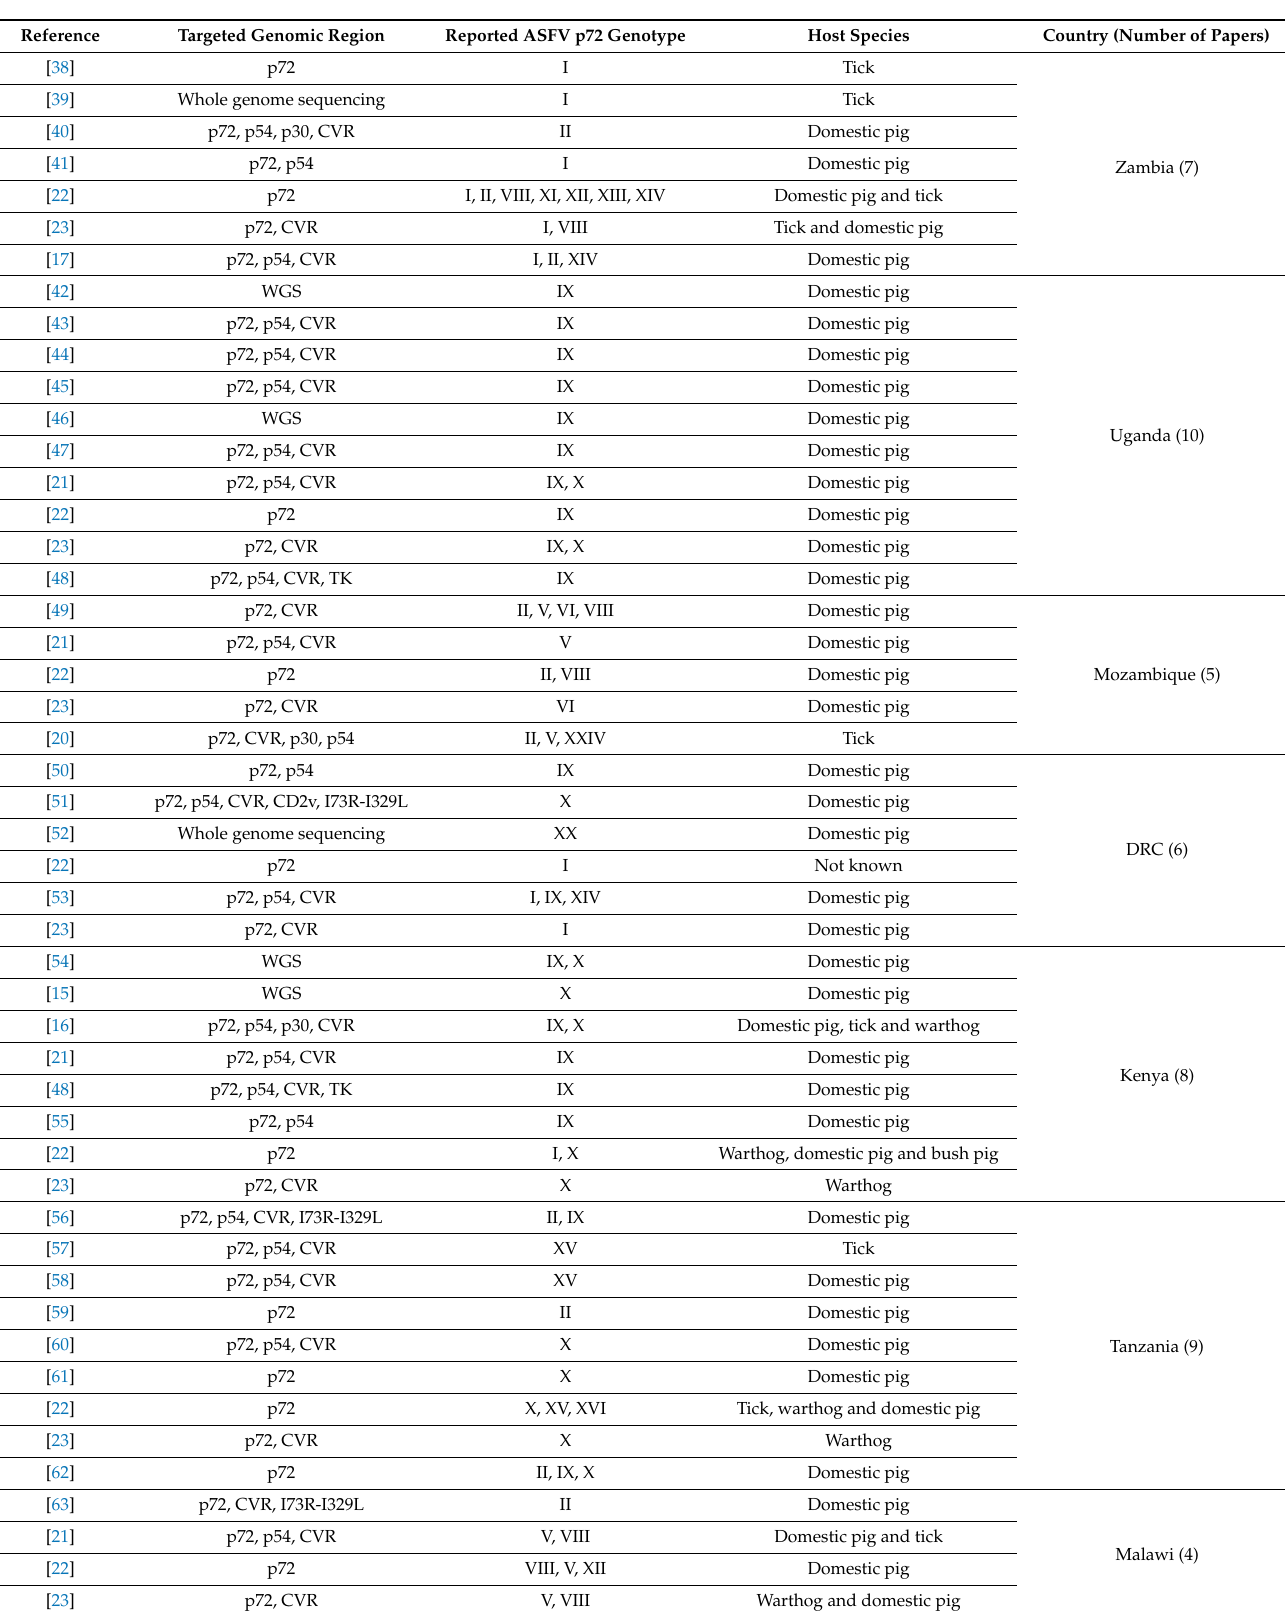
Table 3. African swine fever virus p72 genotypes circulating between Tanzania and its eight neighboring countries